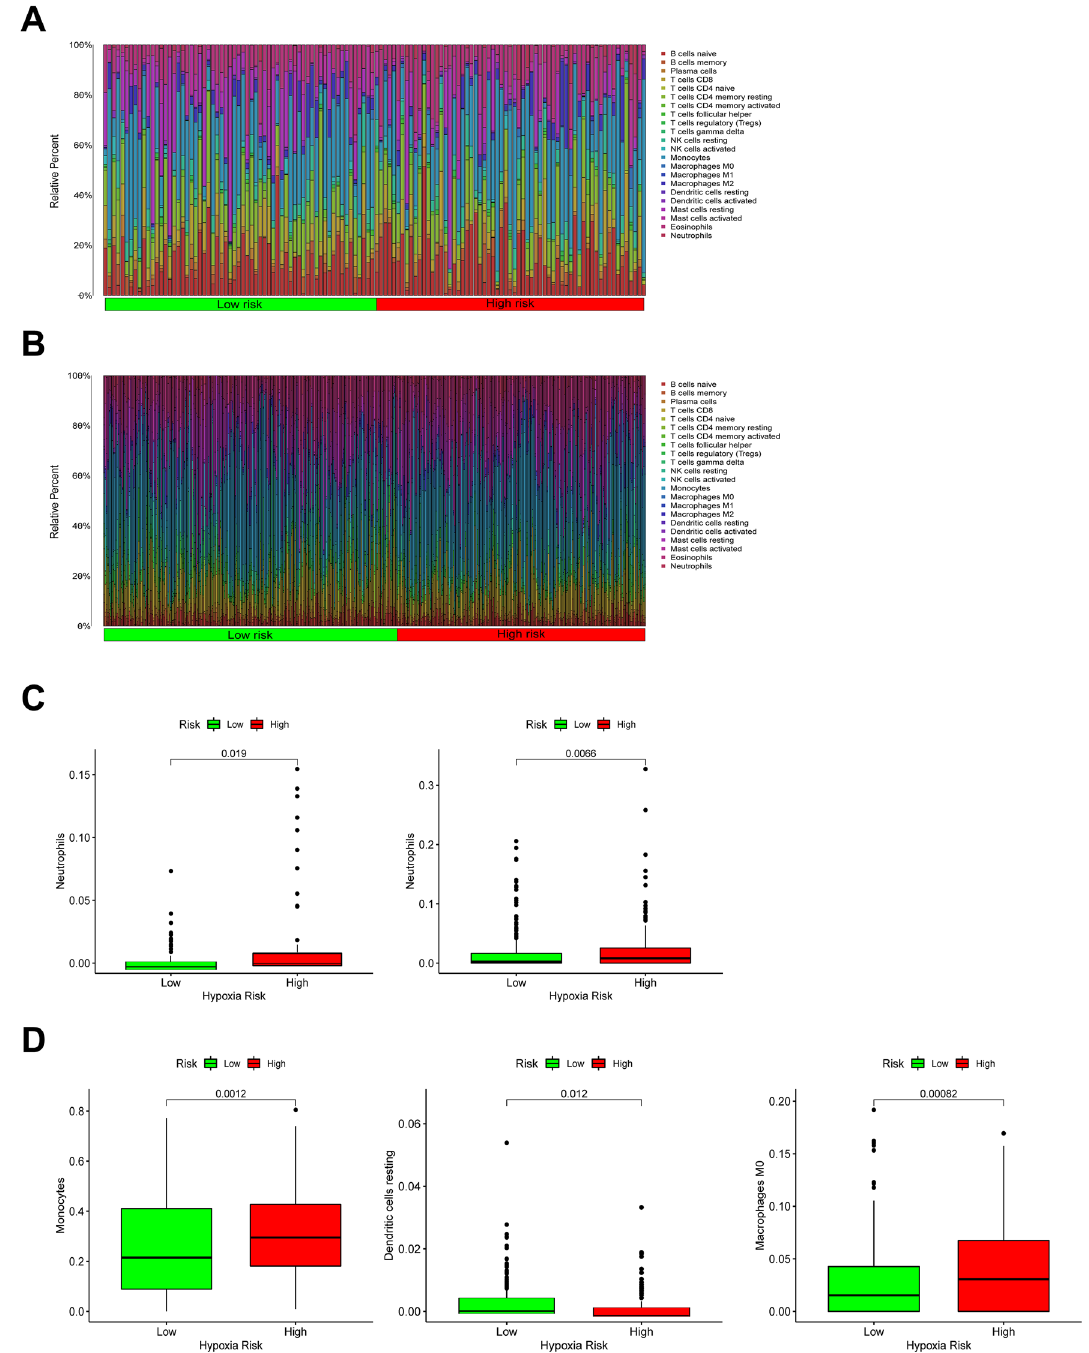
Figure 6. Immune landscape between high and low hypoxia risk groups of AML patients. ( A , B ) Relative proportion of immune infiltration of 22 immune cell types in two hypoxia risk groups in TARGET and GEO; ( C , D ) Box plots showing significantly differences of immune cells between groups with different hypoxia risk